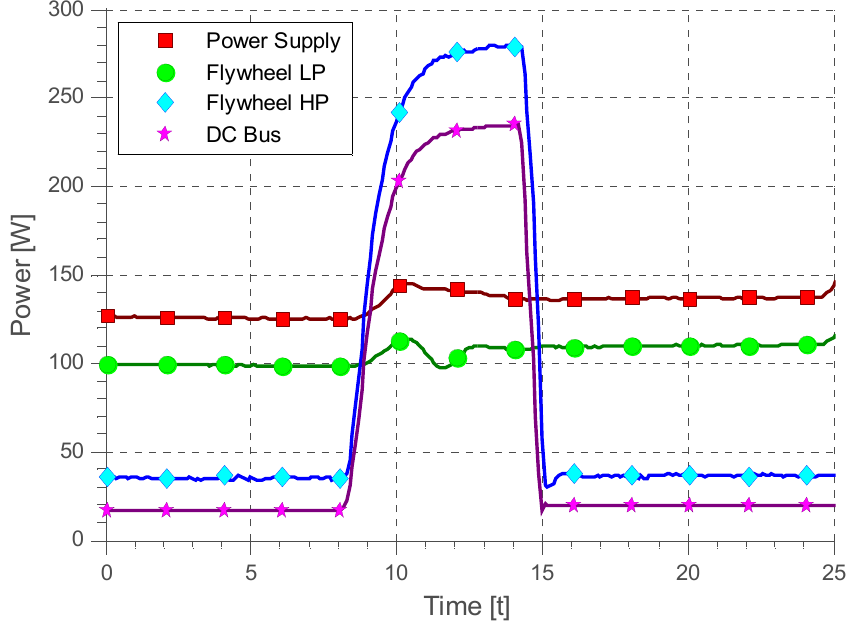
Figure 12. Measurement of power in the driveline during a peak power